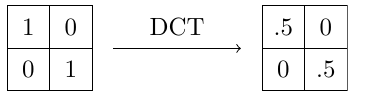
Figure 6. Applying DCT on a 2 × 2